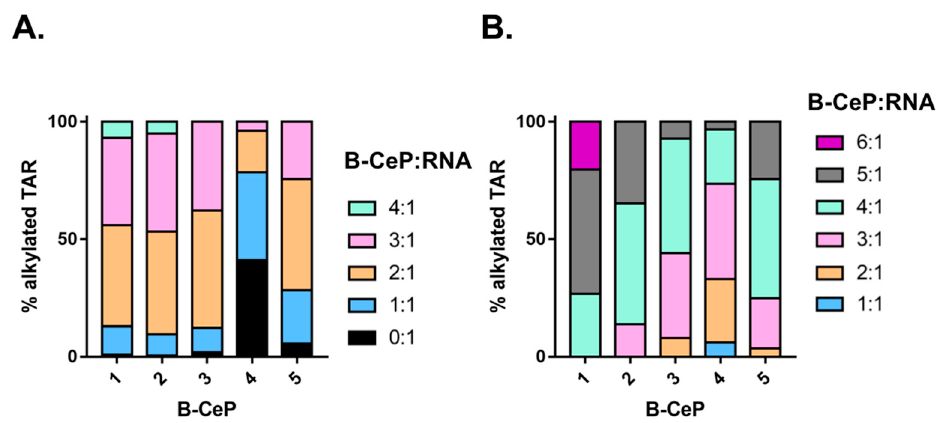
Figure 2. Histograms comparing the percentage of alkylated TAR RNA substrate showing the relative abundances of the detected adducts stoichiometries for B-CePs 1 – 5 . Adduct/TAR ratios are indicated by different colors in the legends. Data were obtained from analyses of the ESI-MS spectra of reaction mixtures containing TAR RNA (1 μ M) and either 10 μ M ( A ) or 50 μ M ( B ) of each B-CePs, incubated for 2 h at 37 °C (see Materials and Methods for details).